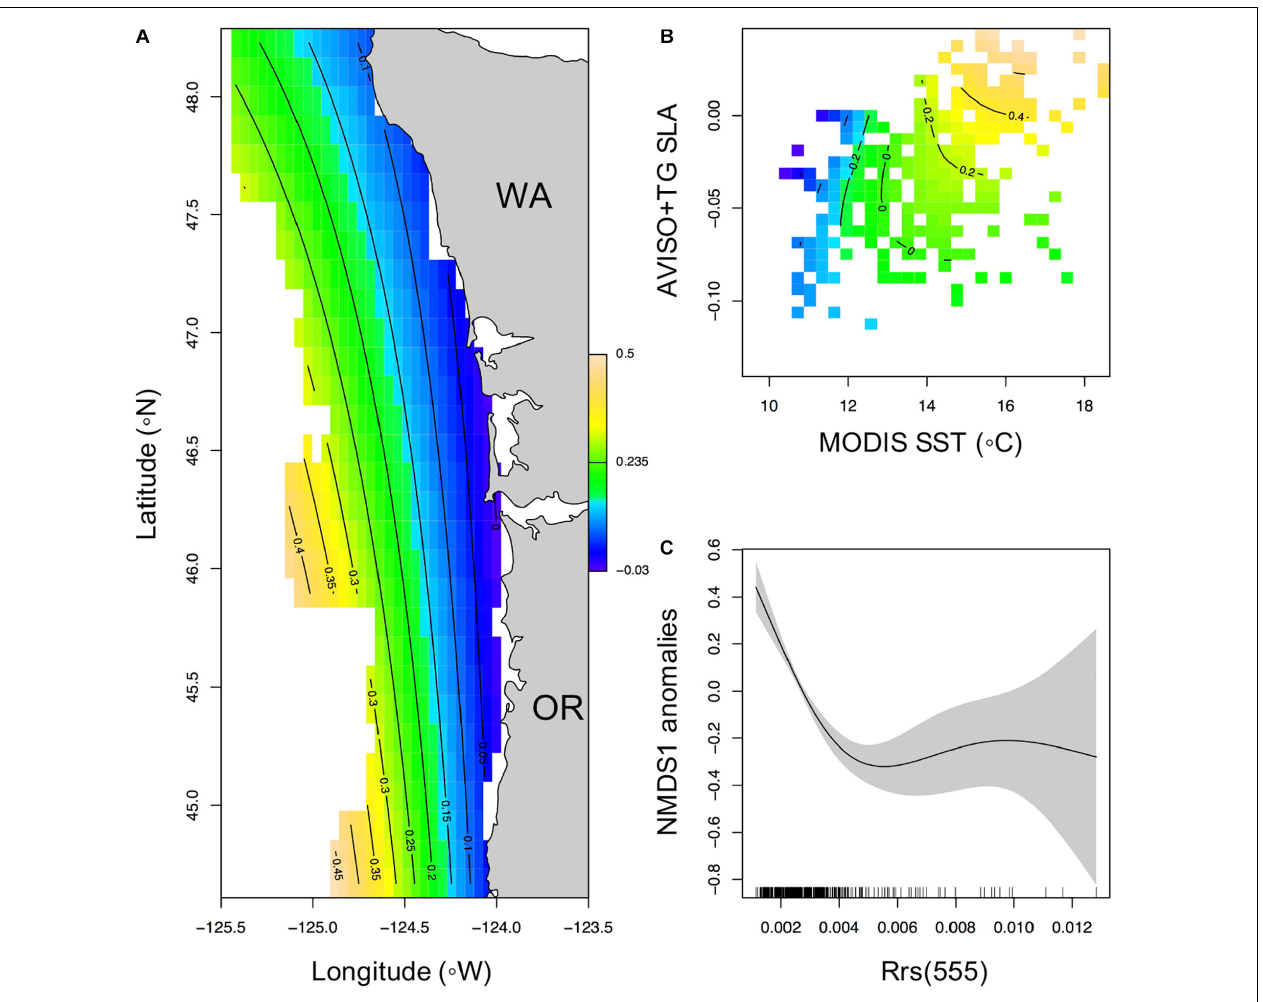
FIGURE 5 | Generalized additive mixed effects model relationships of NMDS axis 1 with significant remotely sensed oceanographic covariates (SST, SLA, and Rrs555). (A) Map of the average spatial distribution of NMDS1 across the sampled time period and area, (B) biplot of the NMDS1 relationship with both SST and SLA, (C) the partial plot of the response of NMDS1 with